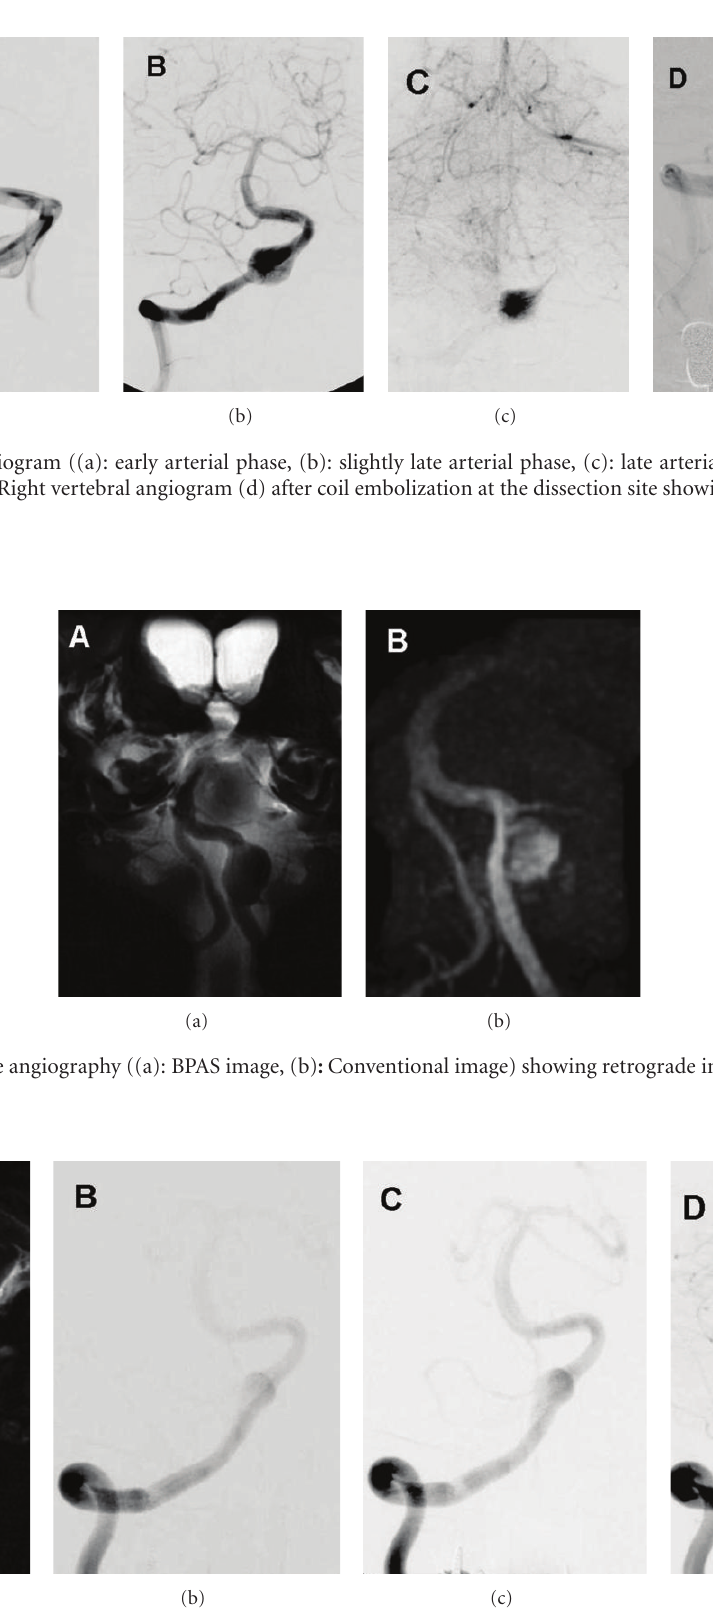
Figure 4: Magnetic resonance angiography ((a): BPAS image) and right vertebral angiogram ((b): ultra-early arterial phase, (c): early arterial phase, (d): slightly late arterial phase) showing retrograde inflow into the